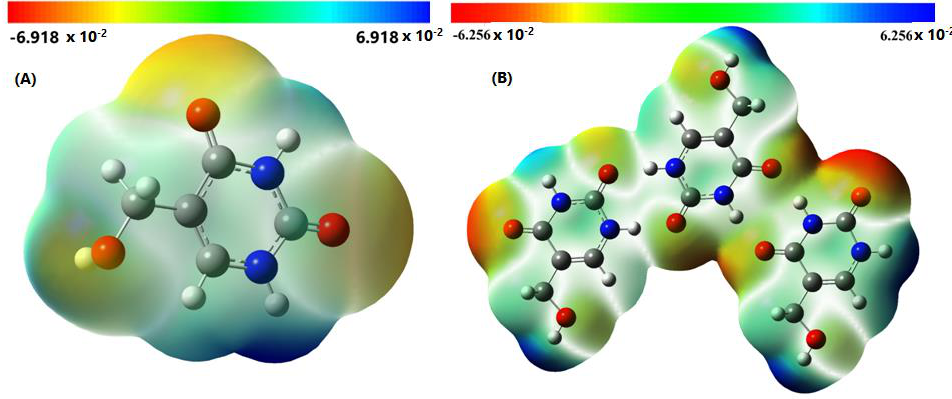
Figure 5 . MEP pattern of